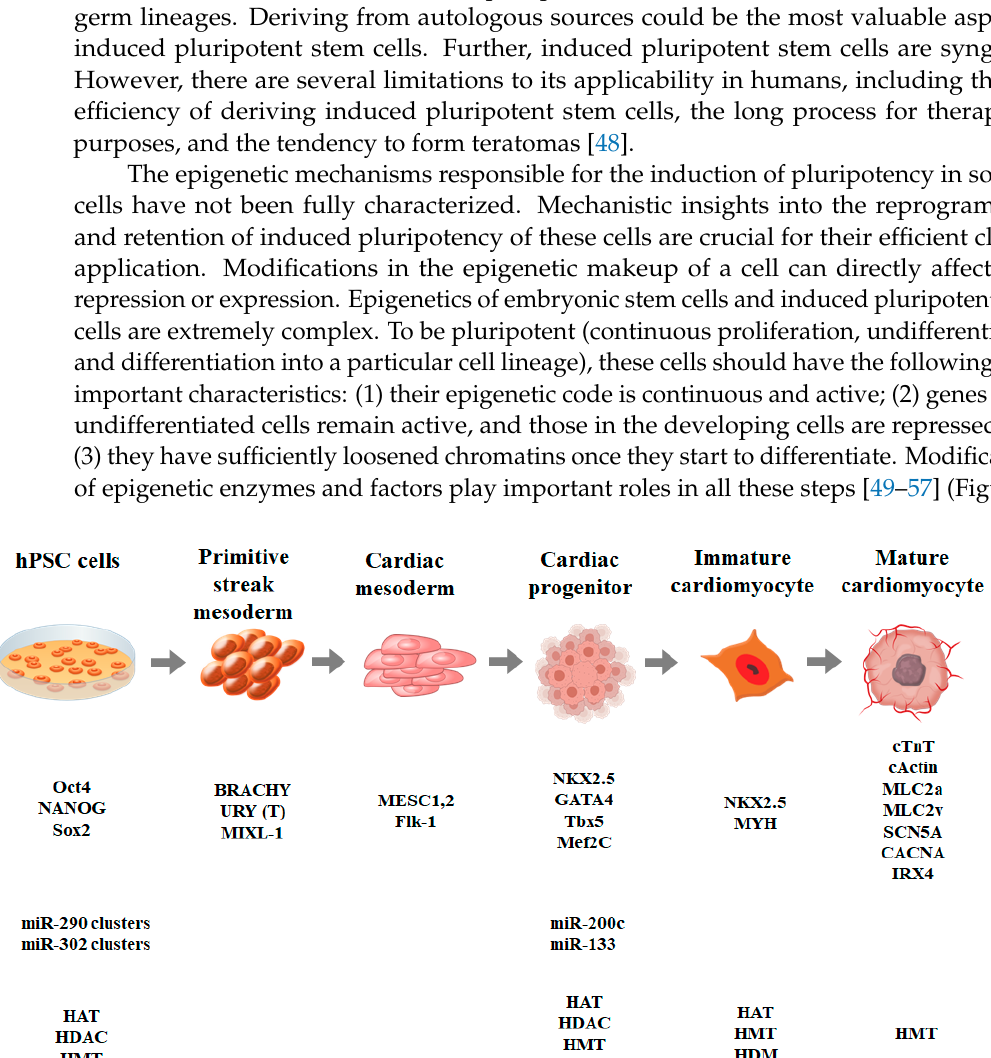
Table 2. Epigenetic histone markers in cardiac-specific gene expression.